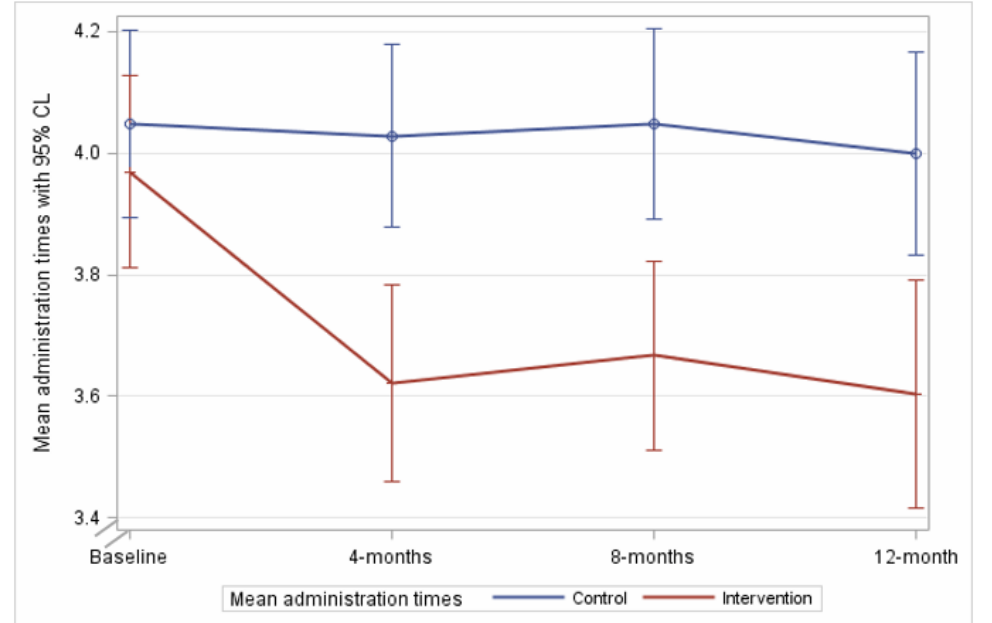
Figure 2. The mean number of medication administration times in 24 h during follow up in the intervention and comparison arms.